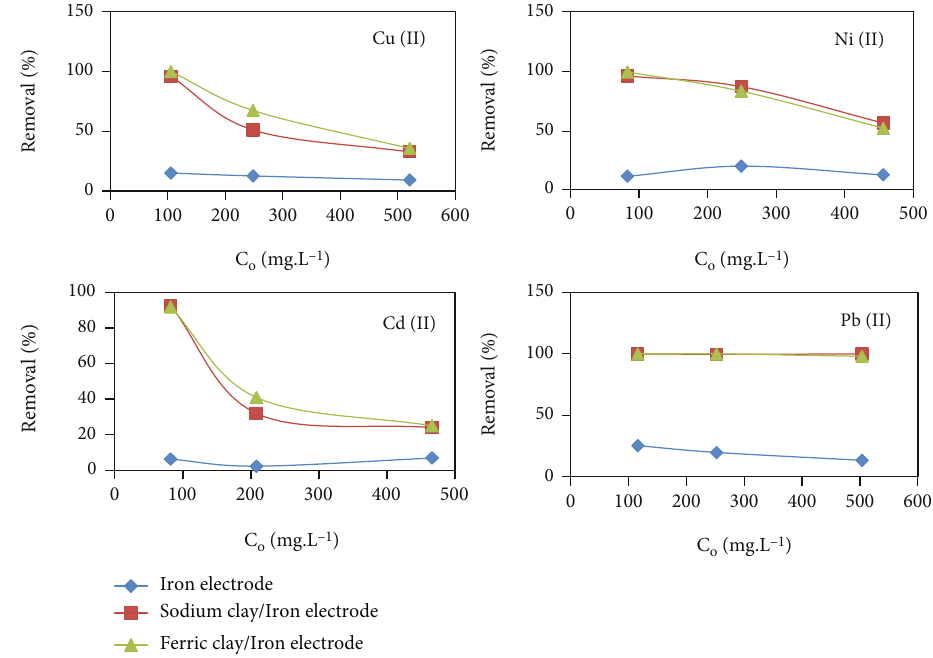
Figure 14: Percentage of removal of Cu(II), Ni(II), Cd(II), and Pb(II) ions in di ff erent systems using Iron electrode. pH = 5 : 5 , T = 28 ° C .